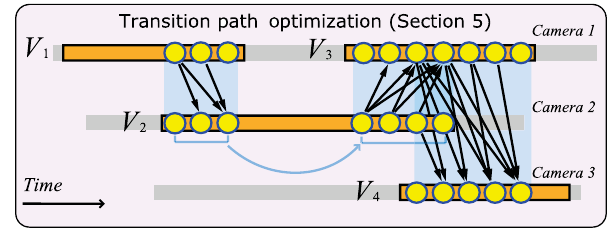
Fig. 3 In our system, a graph model can be used to automatically select a pleasing transition route such that the resulting synthesized video shows the desired foreground objects. Here grey regions denote captures from each camera, orange regions denote shots that contain foreground objects of interest, and black arrows represent possible